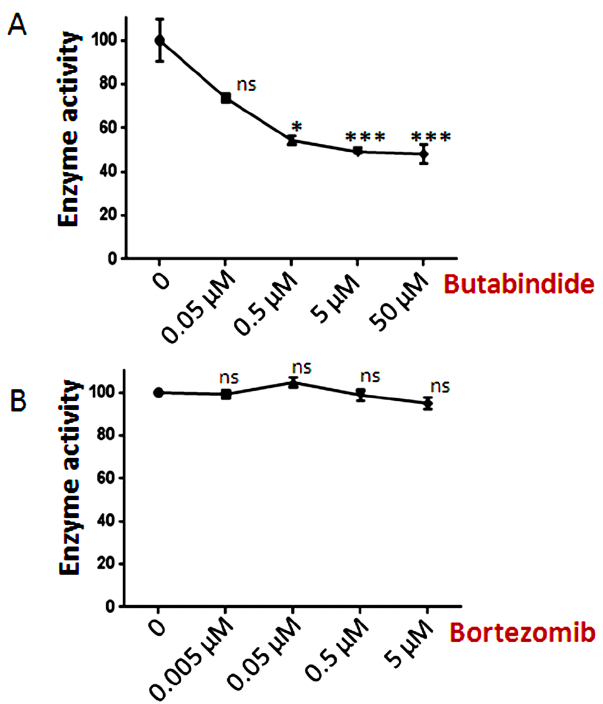
Figure 6. Effect of butabindide and bortezomib on Ala-Ala- Phe-AMC cleavage in HEK293T cells. HEK 293T cell extracts were treated with increasing concentrations of butabindide (Panel A) or bortezomib (Panel B) for 30 minutes in the absence of substrate, and then substrate was added and the reaction incubated for 1 hour. Enzyme activity was determined by fluorescence measurement of AMC and expressed as percentage enzyme activity relative to the control lacking inhibitor. Error bars show standard error of mean (n=3), points without error bars have error ranges smaller than the symbol size. Statistical analysis was performed using Student’s t-test: *, p # 0.05; ***, p # 0.001; ns, no significant difference (p . 0.05) versus the control.